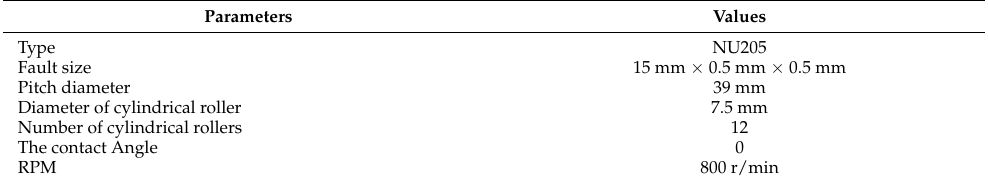
Table 3. Bearing parameter model type.